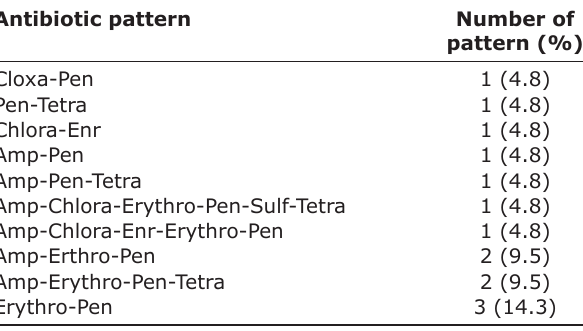
Table-4: The multiple antibiotic-resistant patterns for Staphylococcus aureus i solated from cows’ milk obtained from smallholder farms in Mbeya and Mbozi districts in